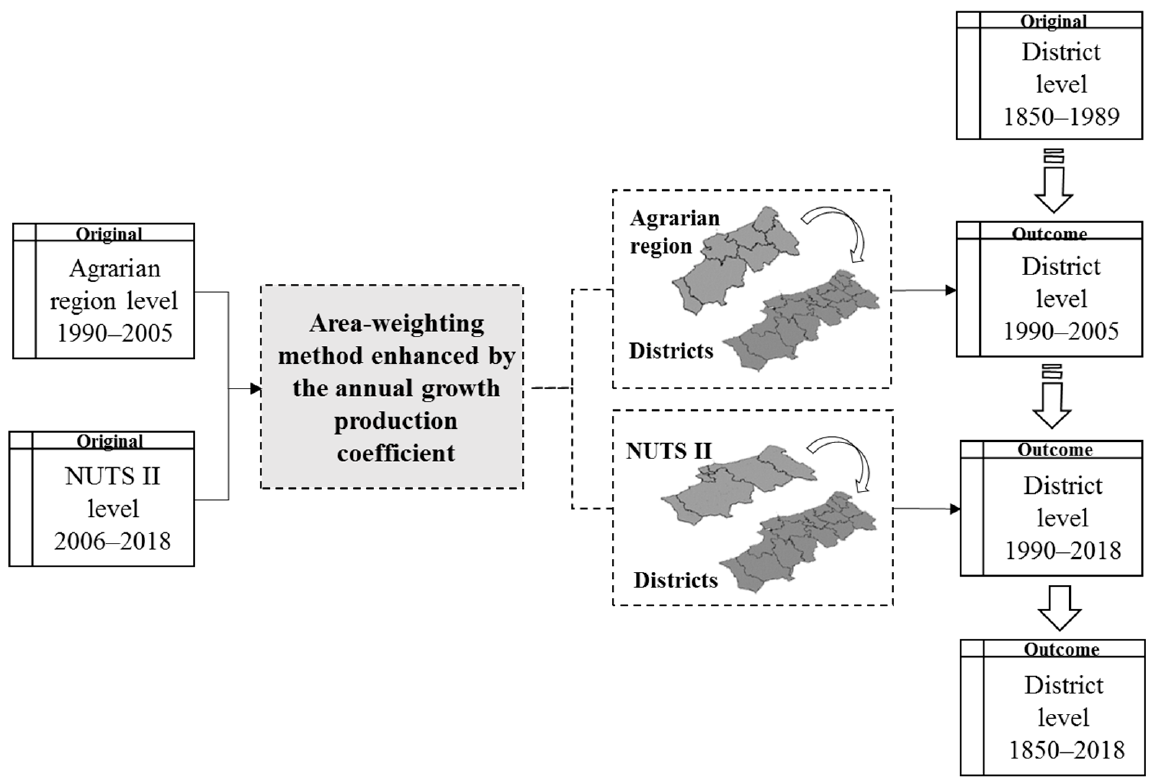
Figure 3. Flowchart of the statistical data homogenization methodology.